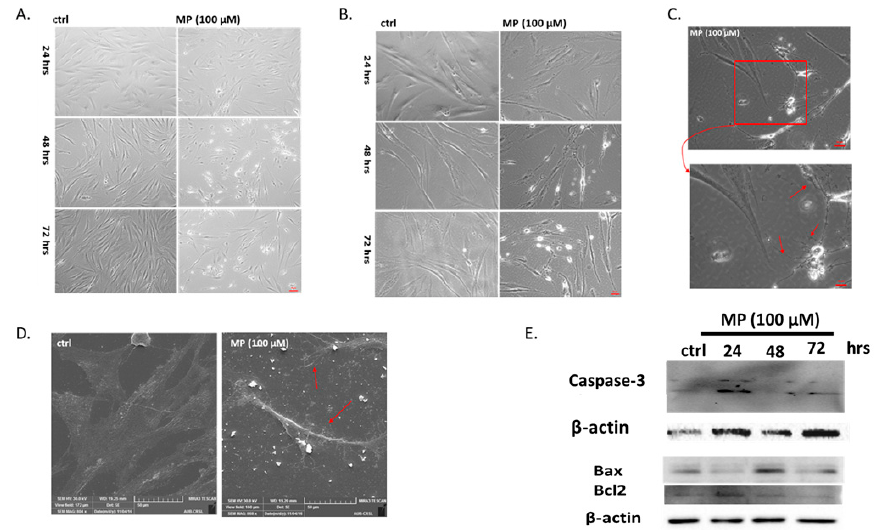
Figure 4. MP induces VSMC apoptosis. Cells were treated with MP (100 µ M) for 24, 48, and 72 h. Micrographs were captured at magnifications of ( A ) 4 × , ( B ) 10 × , and ( C) 20 × . ( C ) The area in the red square was captured at 100× magnification (lower micrograph). ( D ): Representative SEM images of MP-treated cells. Scale bars, 50 µm. In ( C ) and ( D ): Red arrows point at cytoplasmic extensions. ( E ) Cells were treated with MP (100 µM) for 24, 48, and 72 h. Activation of caspase-3 and the expression levels of Bax and Bcl2 were detected by Western blotting. Values mean fold change of three independent experiments. One-way ANOVA followed by Tukey’s test was